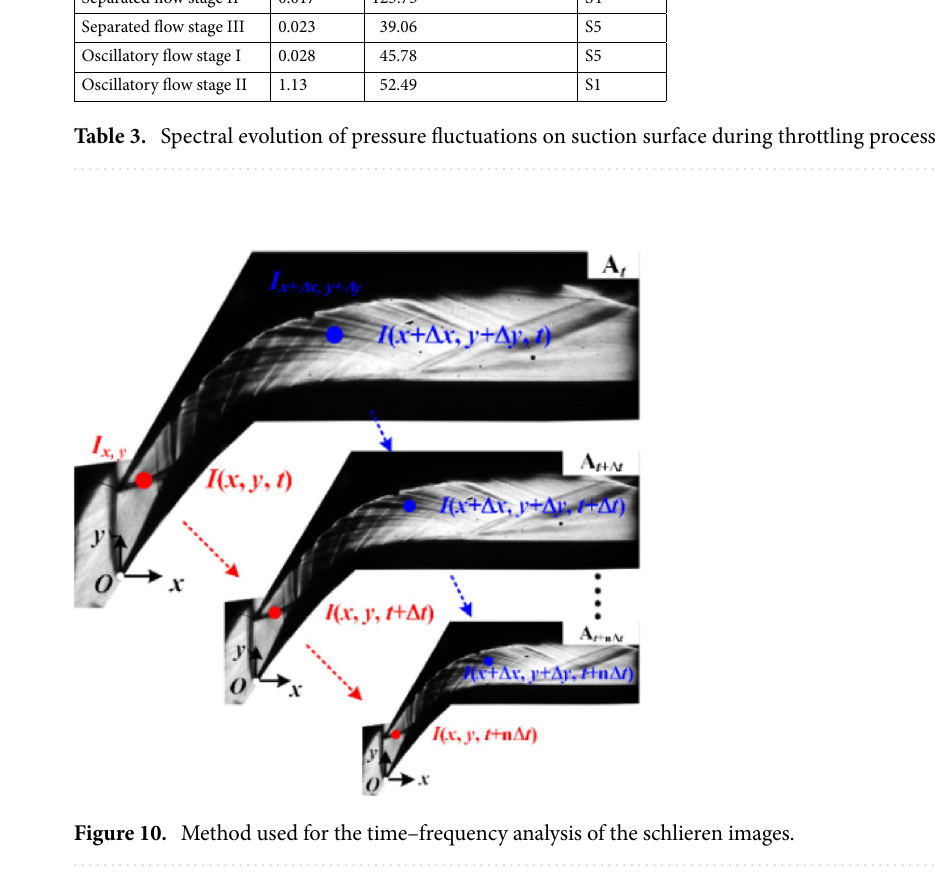
layer in stage II of the separated flow, the main oscillation structures are the reflected shock waves depicted in Fig. 11c,c*. Owing to the greater intensity of the STLS at this point, the reflected shock waves are weaker and the area of high f PSD near the tip of the pressure surface represents the oscillating region of the STLS in stage I of the oscillatory flow. As depicted in Fig. 11f,f*, the area of high f PSD near the suction surface tip indicates the large-amplitude oscillation of the STLS in stage II of the oscillatory flow , which causes fluctuation of the flow field in the downstream cascade channel. Coherence and phase analysis. After understanding the structure of the main oscillation in the flow field, fur- ther coherence and phase analyses are conducted to determine the relationship between the evolution of the different oscillation structures at the dominant frequency. The coherence C αβ ( f ) between two time signals, α( t ) and β( t ), is defined as